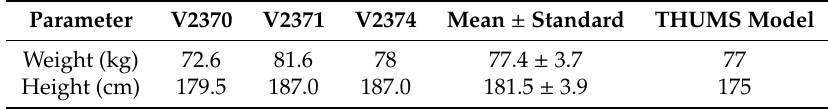
Table 5. The comparison of anthropometry parameters between the subjects [17] we chose and the THUMS